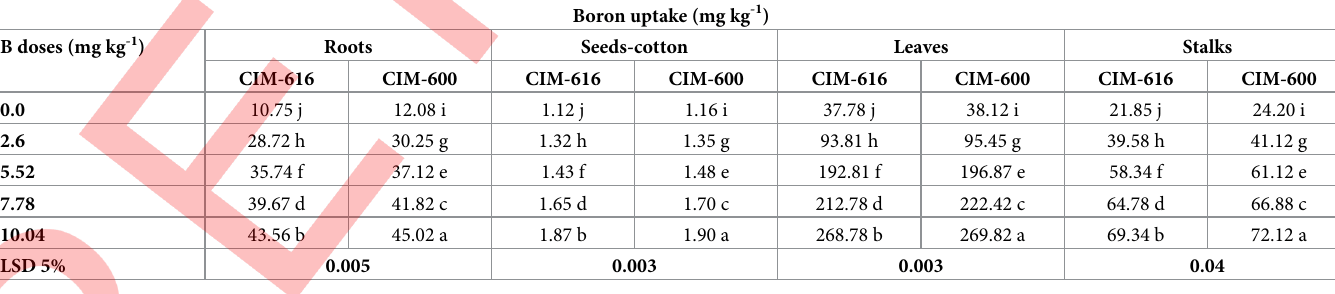
Boron uptake (mg kg -1 )